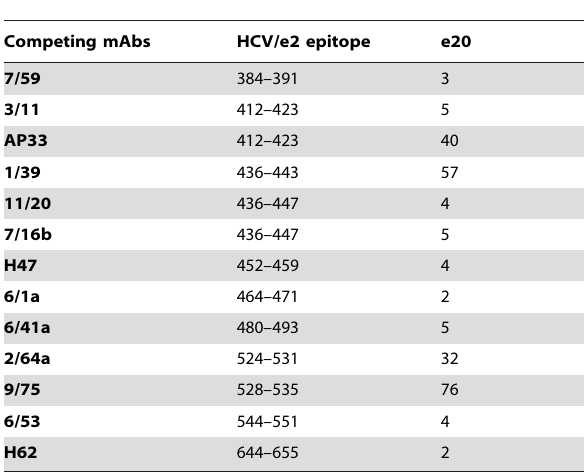
Table 1. Inhibition of human anti-HCV/E2 Fab e20 binding by competing anti-HCV/E2 rat or mouse mAbs directed against known regions of the antigen.